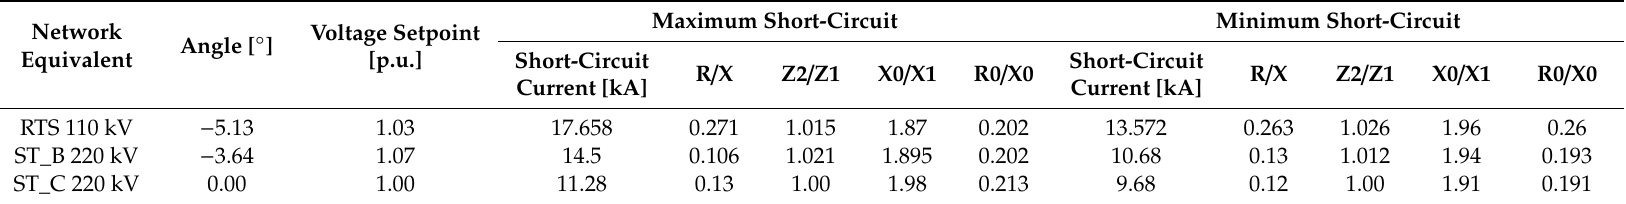
Table A5. Electrical parameters for the network equivalents used in the STS.